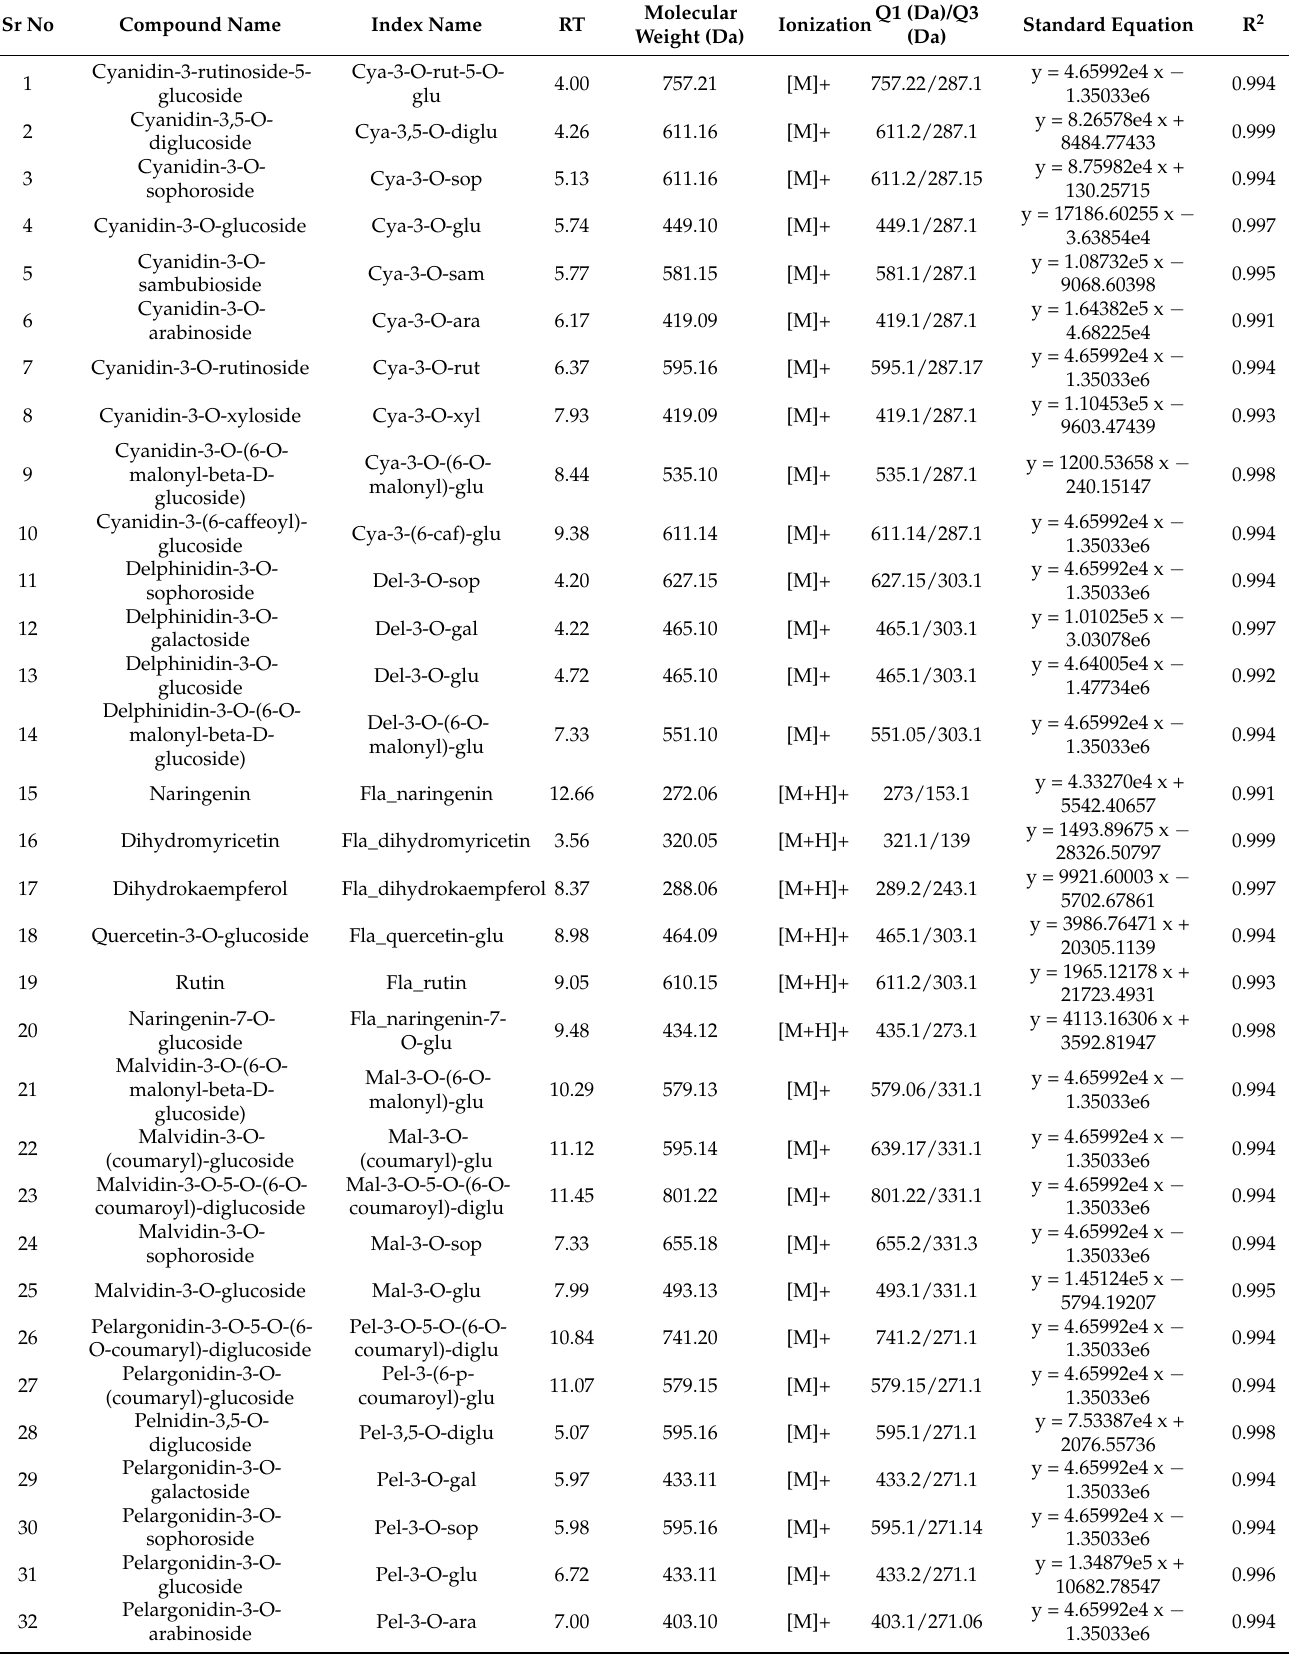
Table 1. Representing the details of quantified anthocyanin compounds from sugarcane